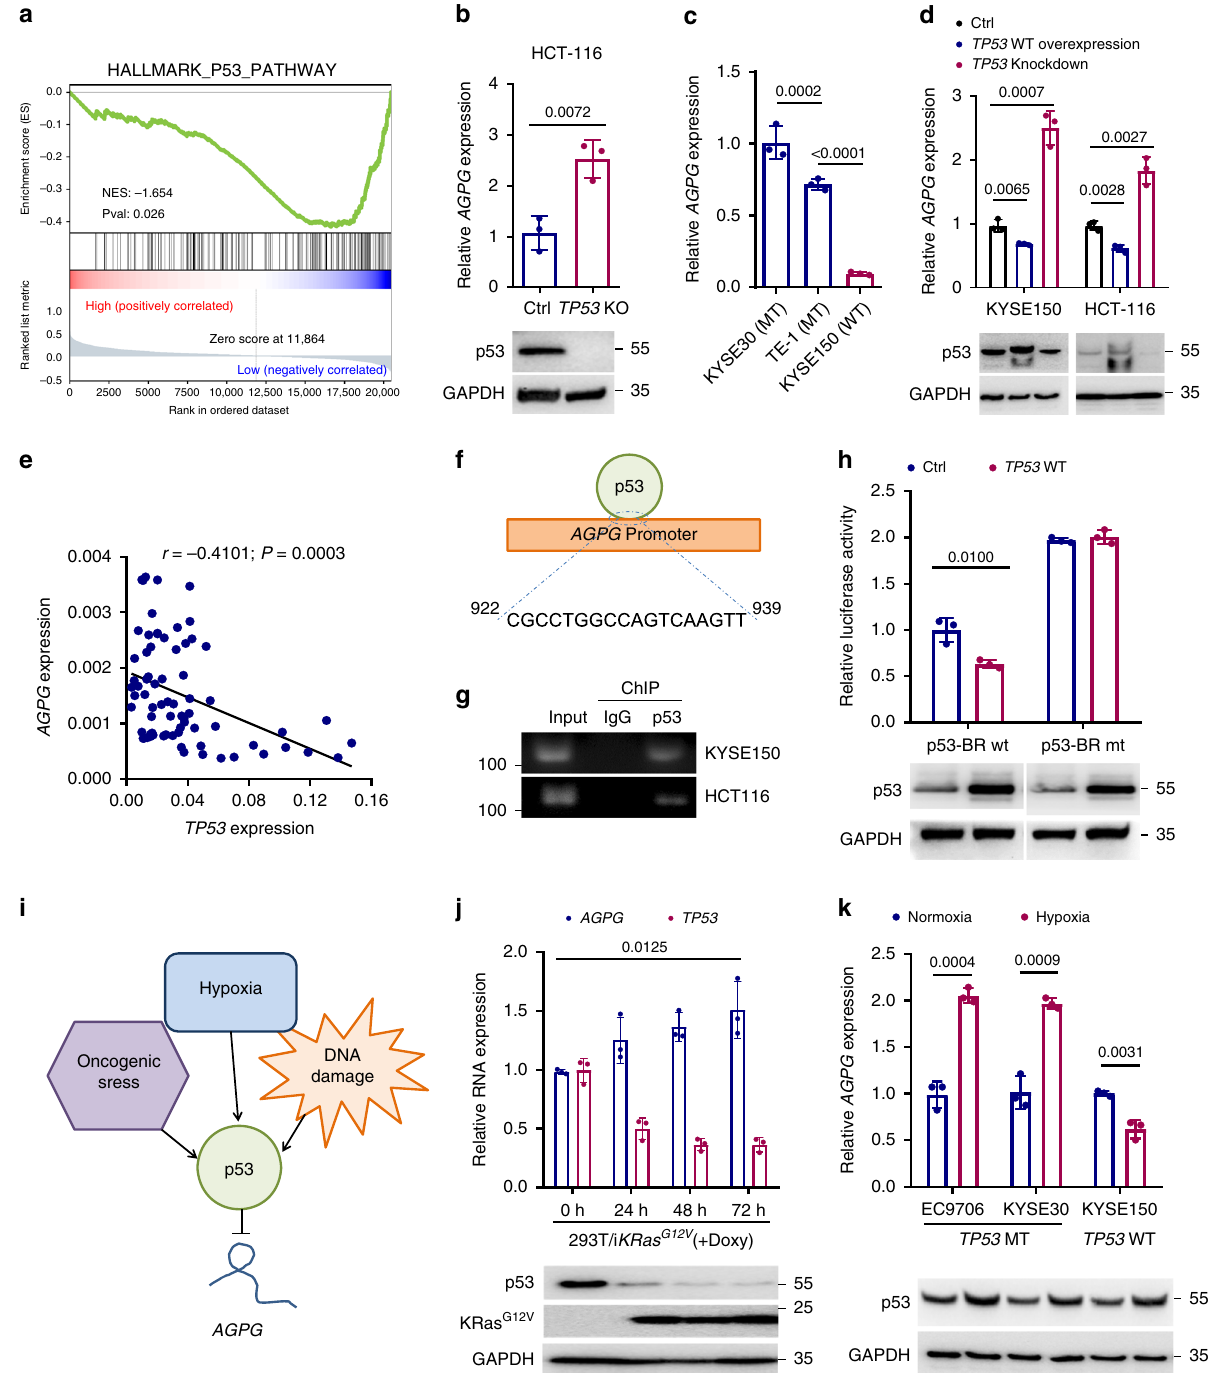
Fig. 5 AGPG is transcriptionally regulated by p53. a Pathway enrichment analysis suggested that AGPG was negatively correlated with p53. The pathway analysis was performed with GSEA method, which was based on an empirical permutation test procedure. b qPCR detection of AGPG expression in TP53 KO and control HCT - 116 cells. c qPCR detection of AGPG expression in ESCC cells with WT TP53 (KYSE150) or MT TP53 (KYSE30 and TE-1). d qPCR detection of AGPG expression in KYSE150 and HCT-116 cells with p53 upregulation or downregulation or control. e qPCR analysis showed that AGPG expression was negatively correlated with TP53 expression in a cohort of ESCC patients with WT TP53 (SYSUCC, Pearson ’ s correlation analysis, n = 72). f The AGPG promoter contains a consensus p53-binding region. g ChIP assays showed that p53 bound to the AGPG promoter. h WT TP53 overexpression diminished the transcriptional activity of AGPG in KYSE150 cells. i Schematic map of the regulatory network involving p53 and AGPG . j qPCR detection of AGPG expression in 293 T cells exposed to oncogenic stress (20 ng per ml doxycycline to induce ectopic KRas G12V expression) for 0, 24, 48, or 72 h. Doxy, doxycycline. k qPCR detection of AGPG expression in cells exposed to hypoxia or normoxia for 48 h. Data in b – d , h , j , k are representative of three independent experiments and presented as mean±S.D., n = 3 biologically independent samples, the P value was determined by a two-tailed unpaired Student ’ s t